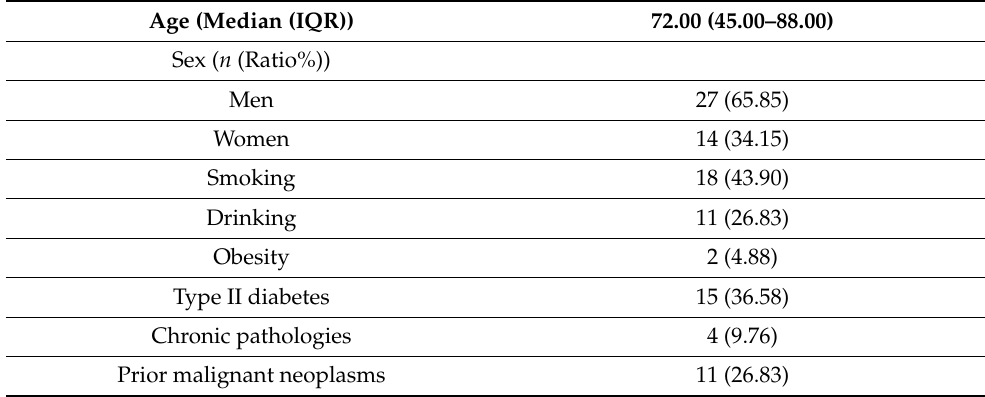
Table A1. Clinical and sociodemographic characteristics of patients diagnosed with pancreatic cancer included in the study. IQR = Interquartile range; n = number of